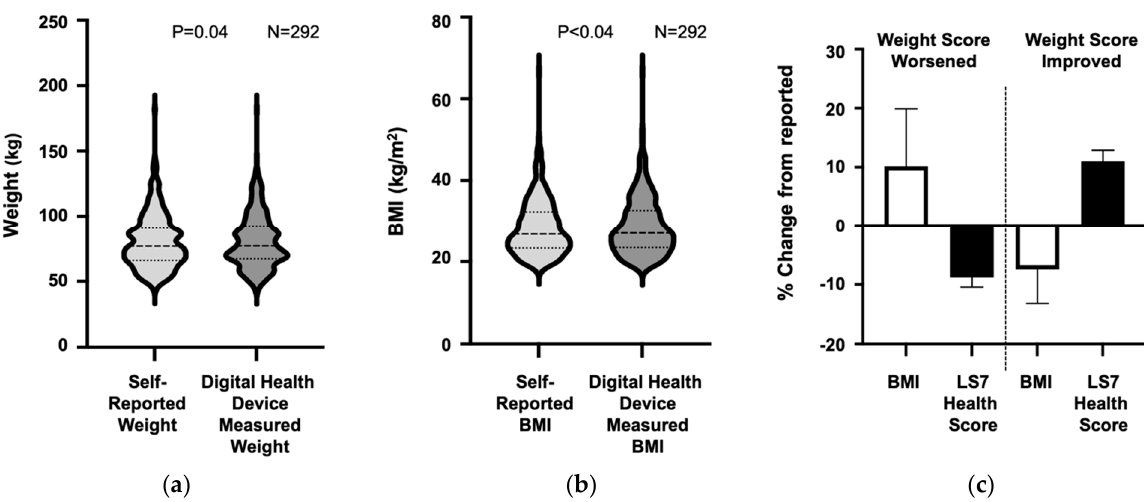
Figure 2. Participant self-reported versus digital-health-device-measured weight and body mass index. Participant self- reported ( a ) weight and ( b ) calculated body mass index (BMI) are compared with weight measured by digital devices and BMI calculated using digital-health-device-measured weight. Data are summarized graphically in violin plots. Median and quartiles are denoted by dashed lines n = 292). ( c ) There are both increases and decreases in weight identified by digital health devices within the study population. The effect of a large difference in measured versus reported weight, change in Weight Score, and the resultant effect on Life’s Simple 7 Health Score is illustrated. Digital-device-measured weight was used to calculate body mass index (BMI) and a Life’s Simple 7 Weight Score. In 18 participants, the digital-device-measured BMI was significantly higher than the participant’s self-reported weight and the Weight Score decreased by one class. The digital health device Weight Score was used to calculate the Life’s Simple 7 Health Score. Thirteen participants overestimated their weight (and BMI) resulting in a better Weight Score and overall Life’s Simple 7 Health Score. LS7, Life’s Simple 7.